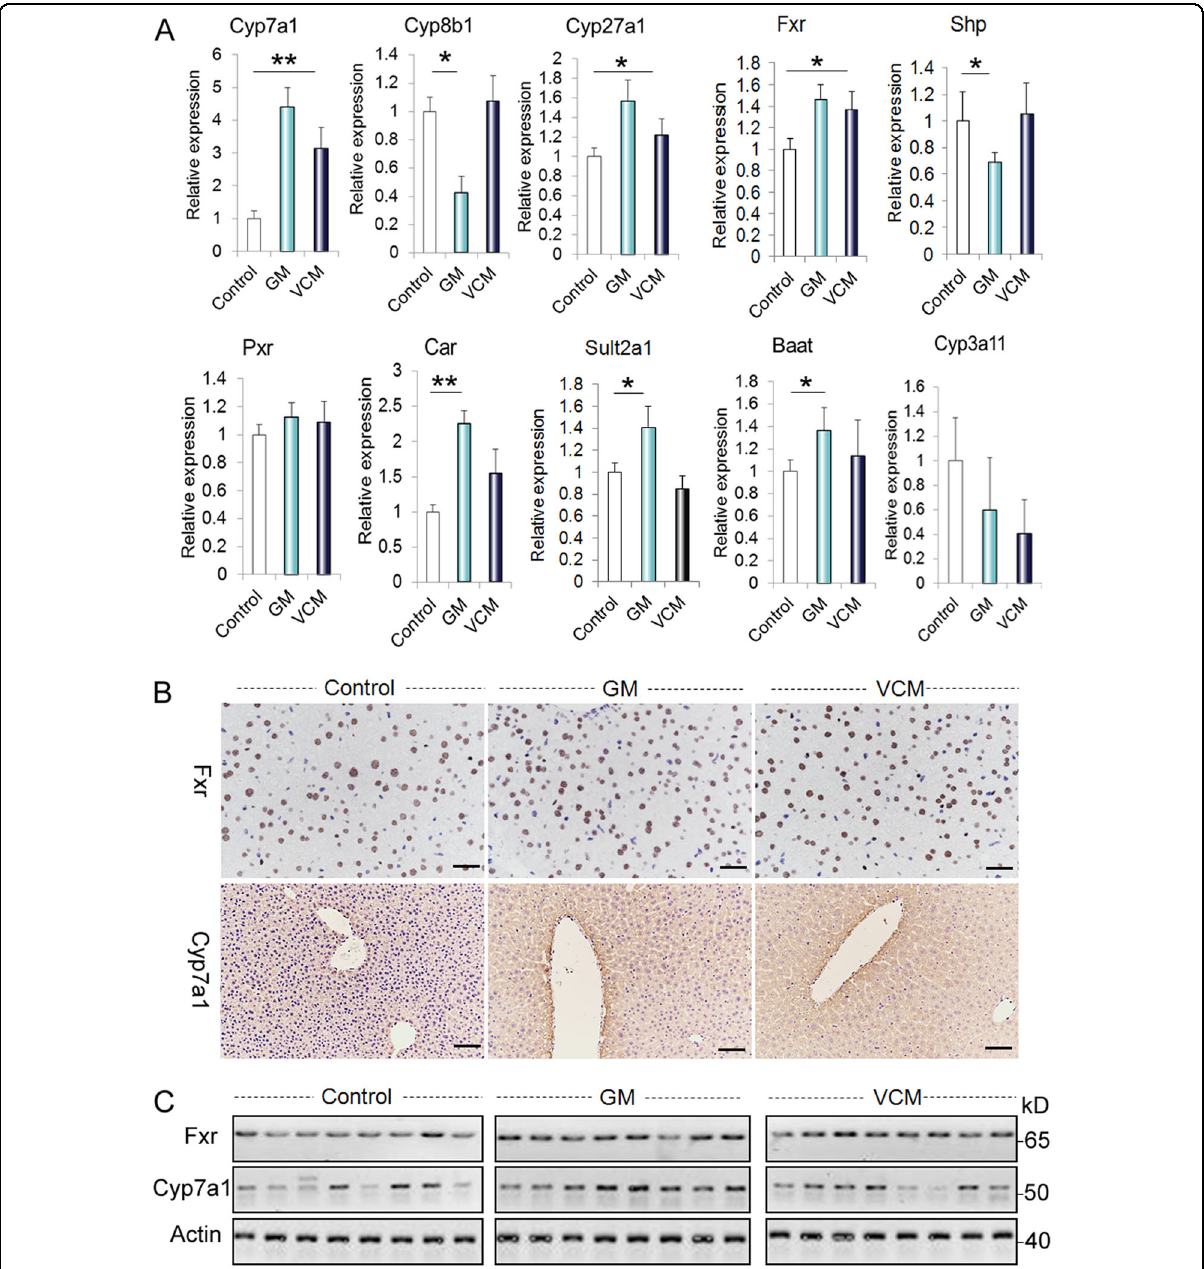
Fig. 4 Analysis of the bile acid synthesis pathway in the liver. a Gene expression changes in bile acid synthesis enzymes and Fxr in untreated and antibiotic-treated animals. b , c Protein expression changes in the bile acid synthesis enzymes Cyp7a1 and Fxr in untreated and antibiotic-treated animals. Scale bar = 25 µm; * p < 0.05, ** p <